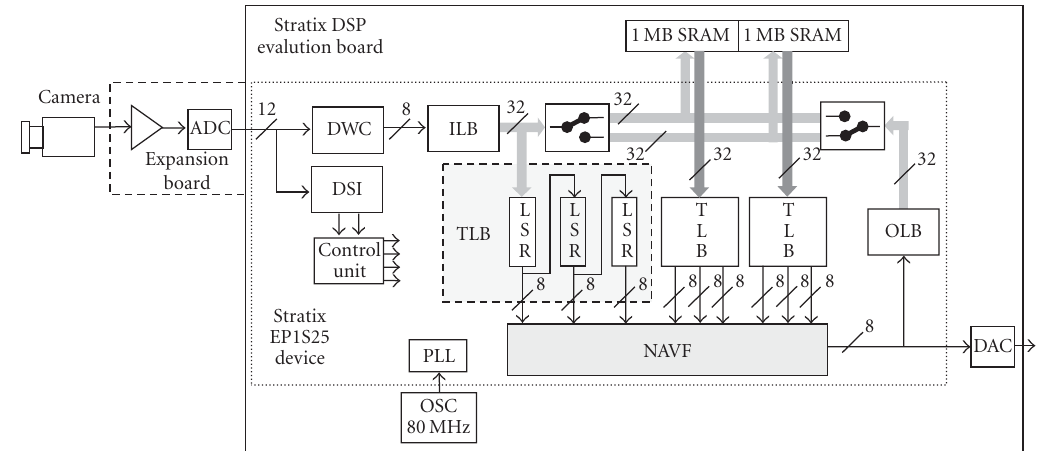
Figure 11: Block diagram of the complete video filtering system based on the 3D reduced NAVF